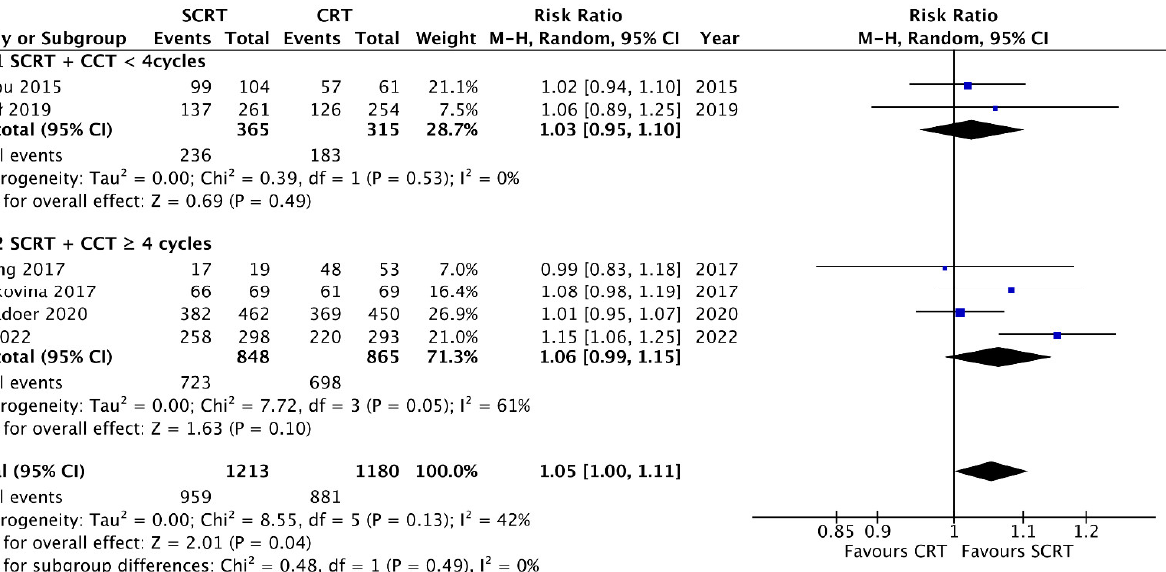
Figure 10. Forest plot for subgroup analysis of the overall survival (OS) events according to consol- idation chemotherapy cycles.